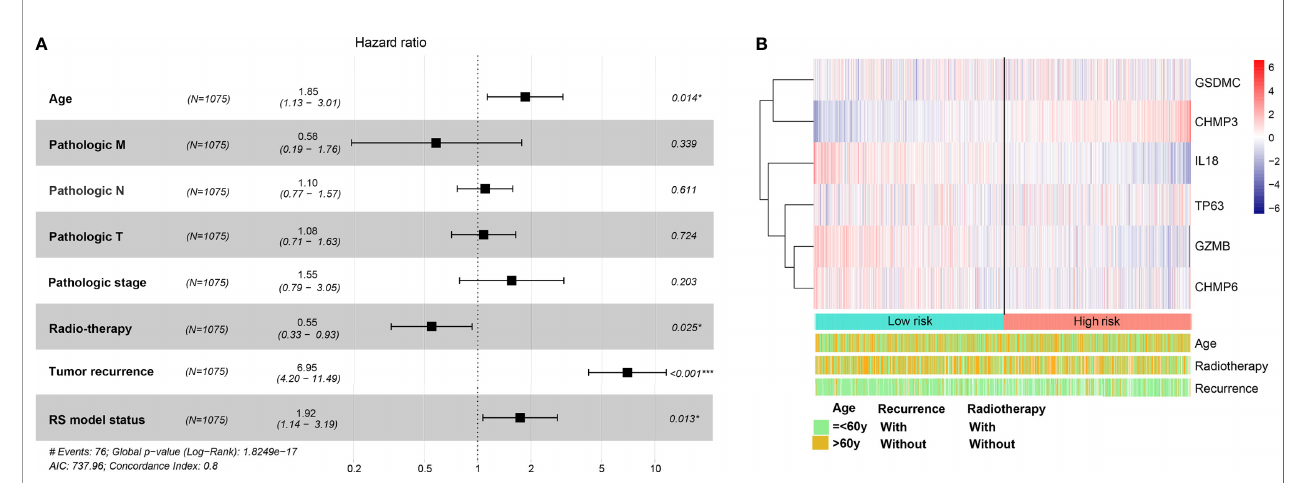
FIGURE 6 | The univariate and multivariate Cox regression analysis for prognostic signature. (A) Forest plot for the prognosis of clinicopathologic characters. (B) Heatmap for the connections between the expression levels of six optimal PRGs and the distribution of the independent prognostic factors. Red: up regulated; blue: down regulated. *p<0.05, ***p<0.001.